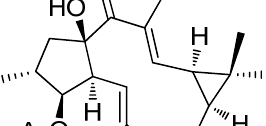
Figure 14. Structure of jatropodagin A ( 96 ).